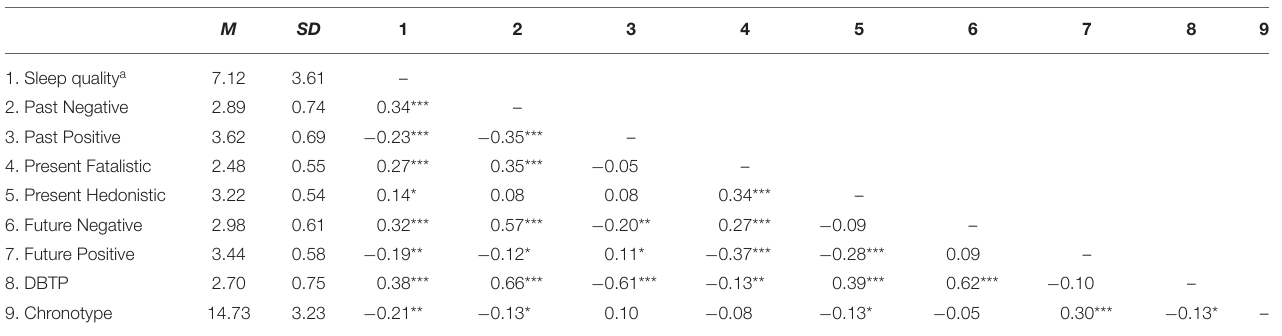
TABLE 1 | Descriptive statistics and zero-order correlations of the study